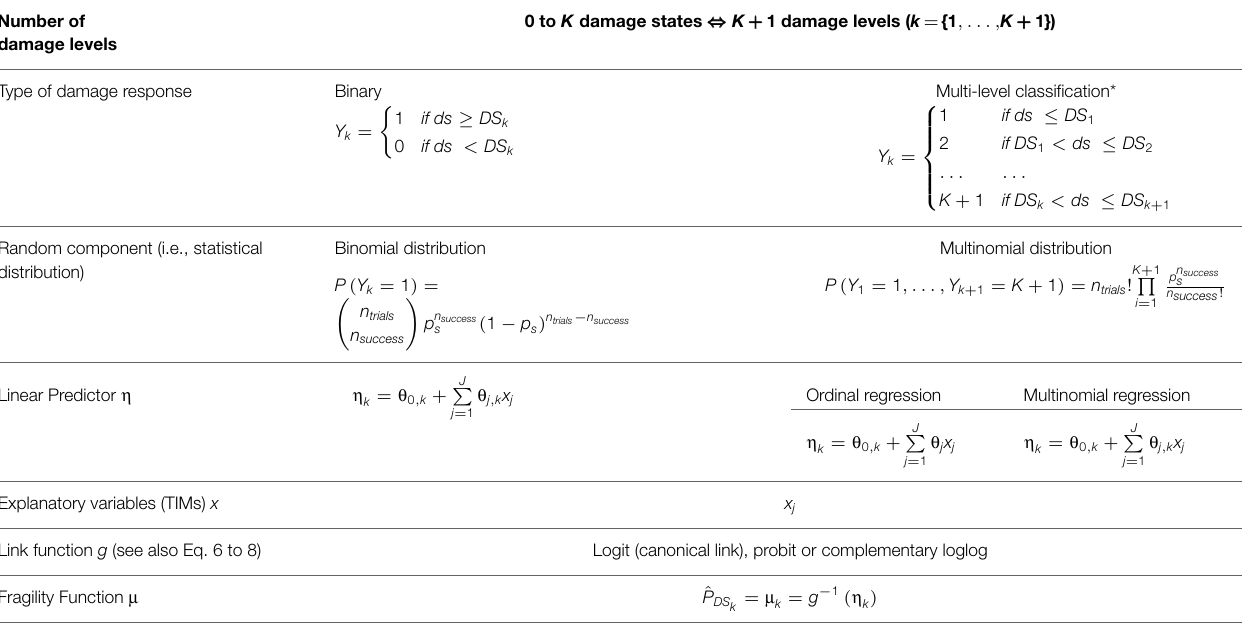
TABLE 9 | GLMs used for fragility function